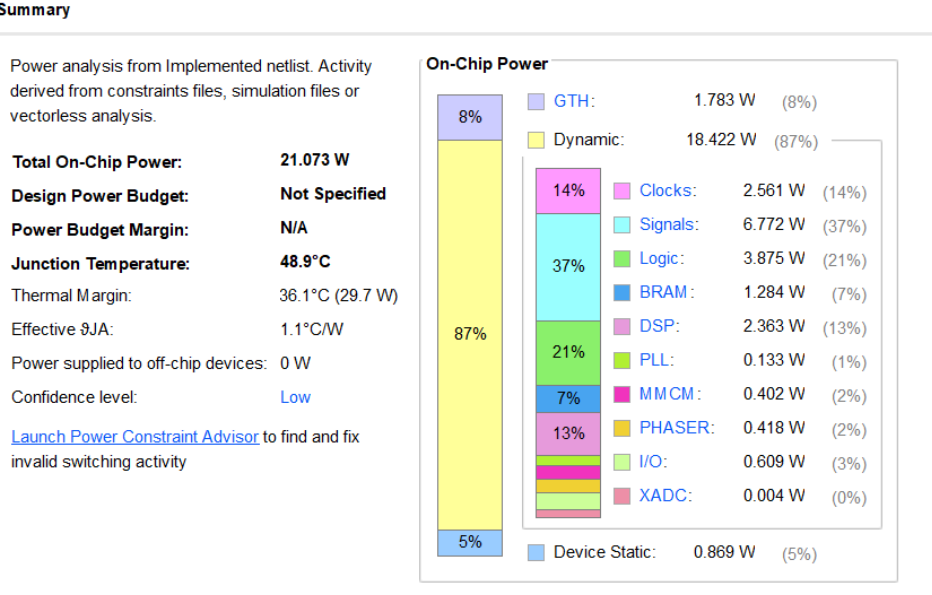
Table 4. Comparison of processing time